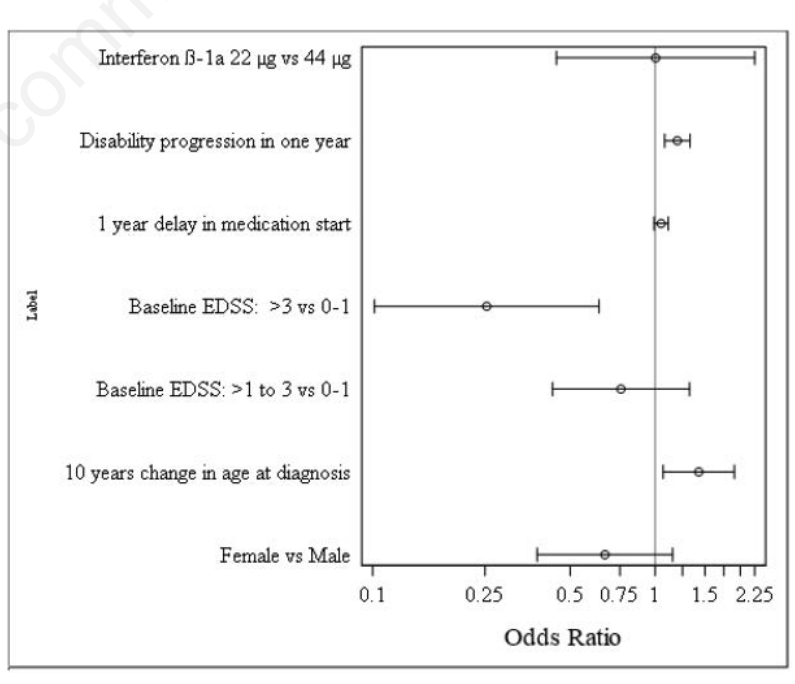
Figure 3. Longitudinal analysis showing OR’s with 95% confidence intervals by clinical prognostic variables. Disability progression risk is increased if OR > 1.0 during the treat- ment